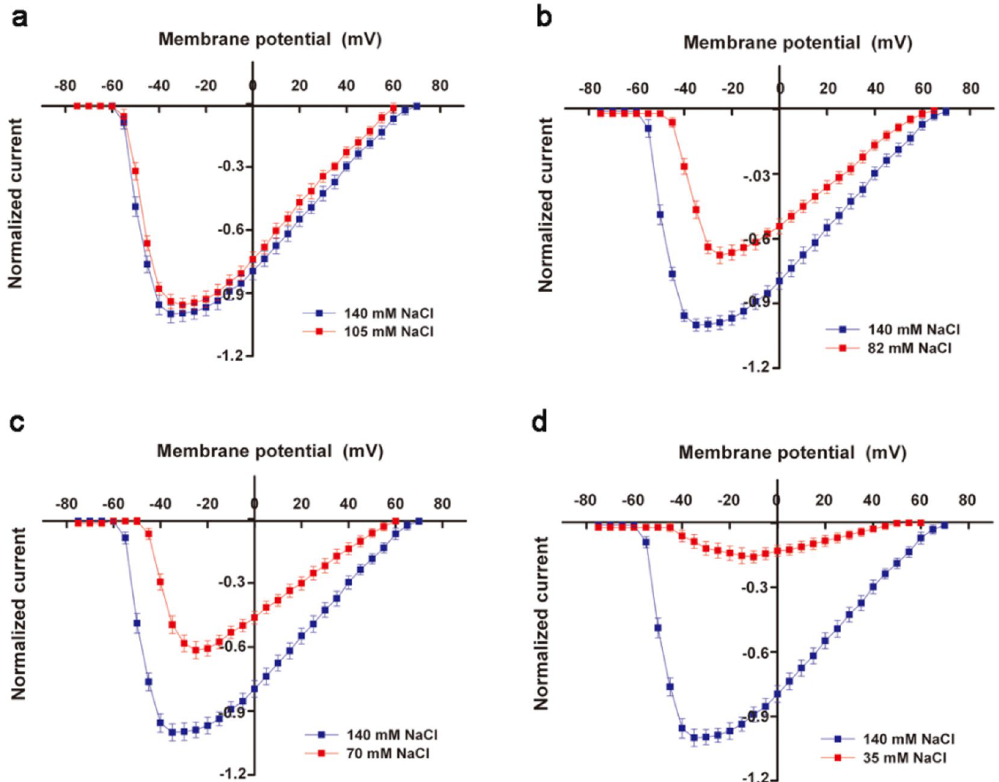
Figure 2. Impact of Na + concentration change in extracellular fluid on normalized I Na I/V curve of cardiomyocytes. When the NaCl concentration in the extracellular fluid decreases from 140 to 105 mM, 82 mM, 70 mM and 35 mM, the normalized I Na I/V curve changes as shown in the figure. The peak values of 82 mM, 70 mM and 35 mM NaCl groups were compared with the control group, P <